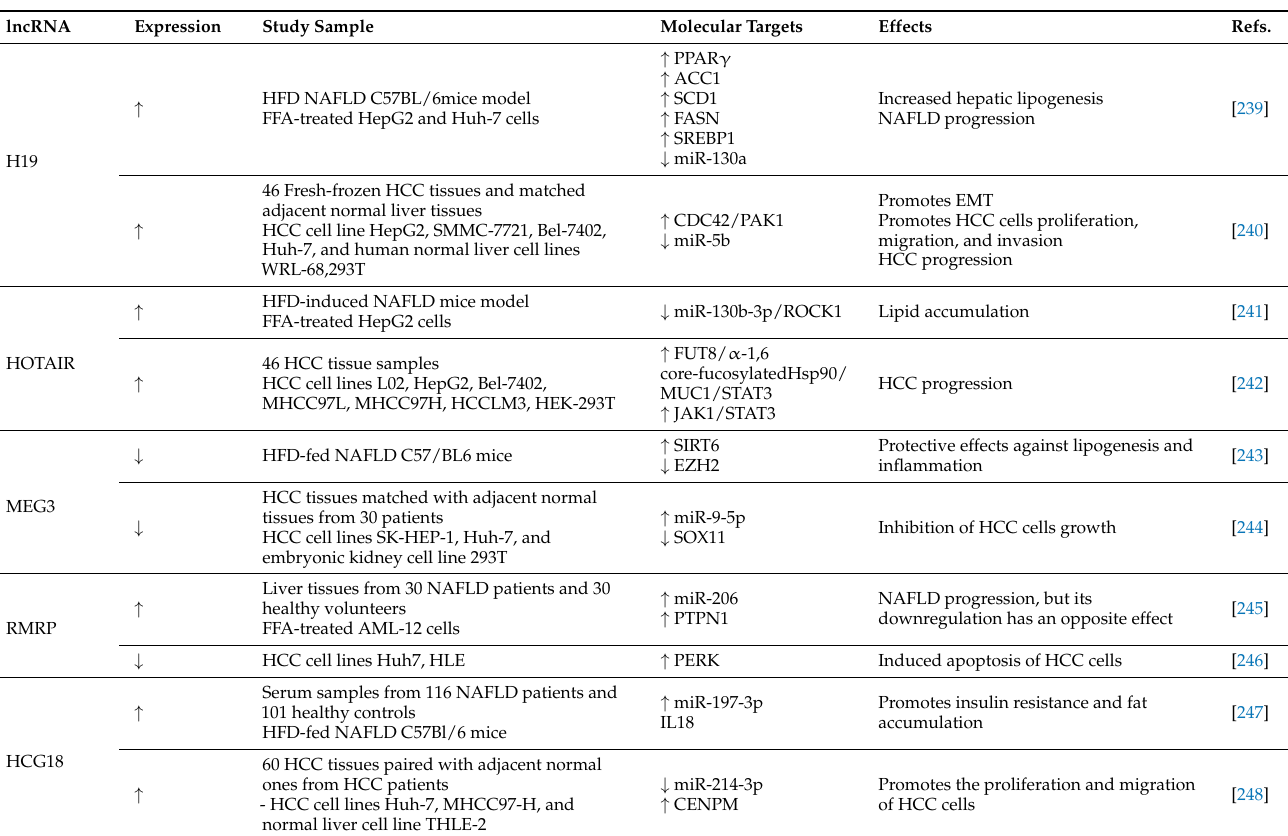
Table 2. Other dysregulated lncRNAs involved in both NAFLD and